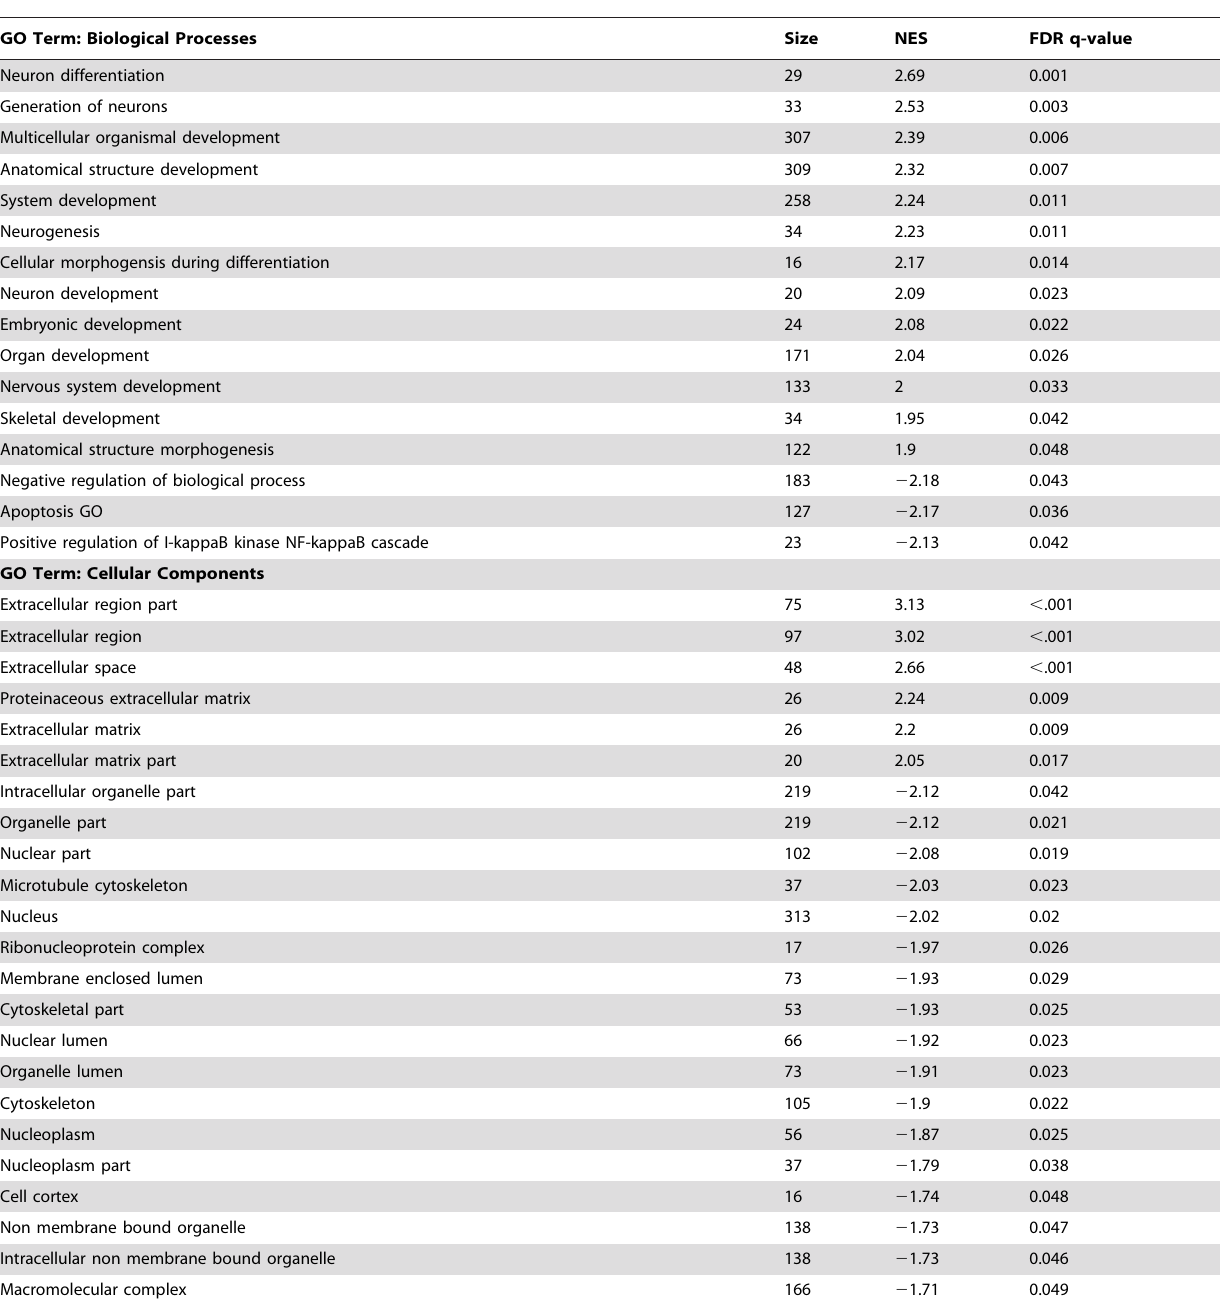
Table 4. Gene enrichment analysis of CpG sites that associated with GA (FDR ,